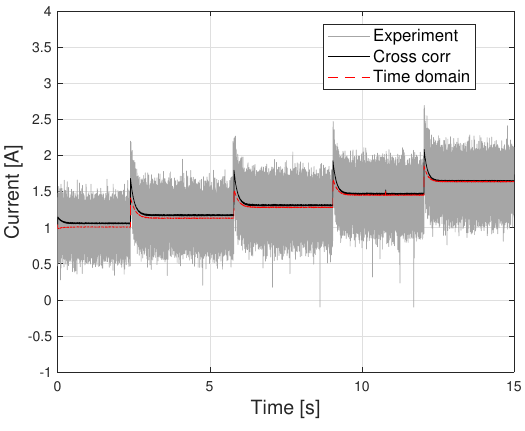
Figure 11. Current time history of the staircase